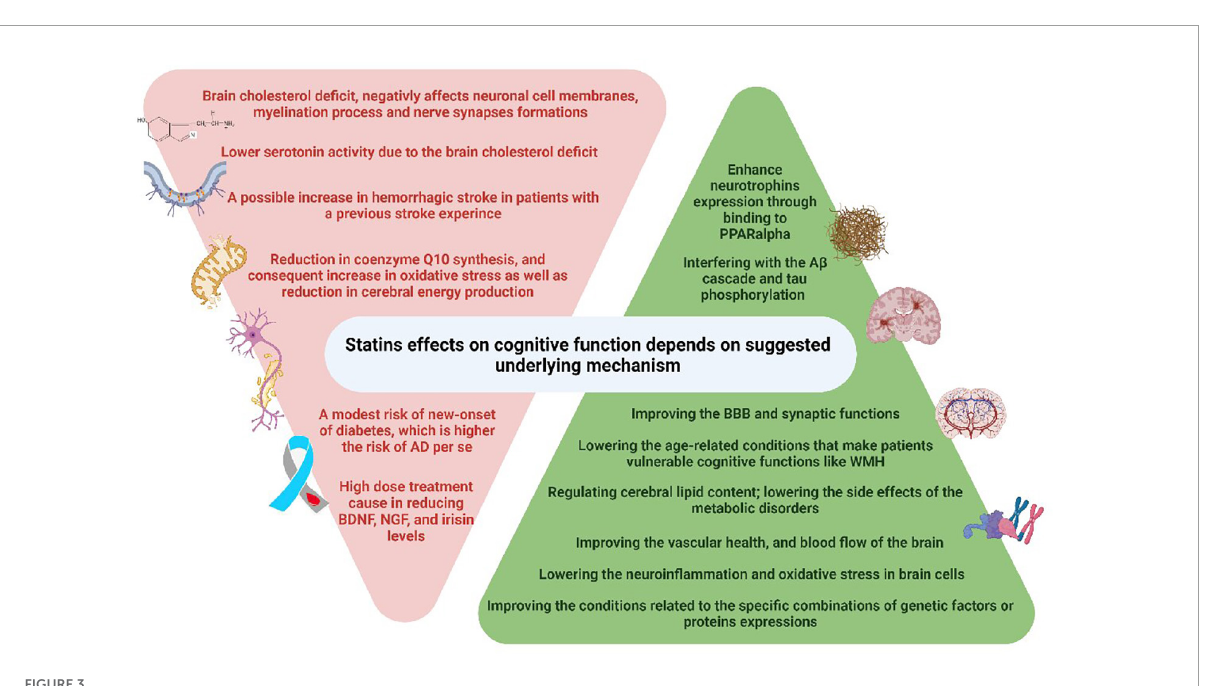
FIGURE3 Underlying mechanisms for statins’ detrimental and beneficial effects on cognitive